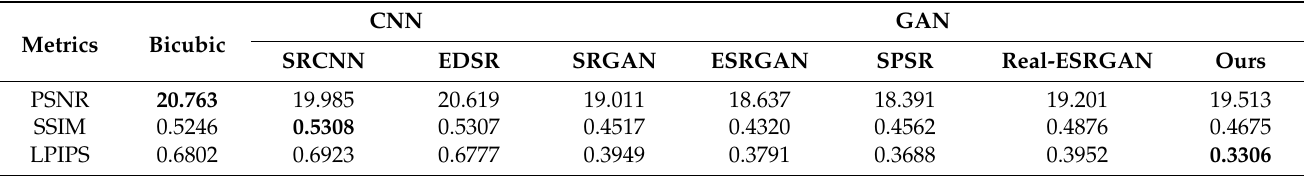
Table 3. Mean values of PSNR, SSIM and LPIPS for different methods. The best performance in bold. CNN GAN Metrics Bicubic SRCNN EDSR SRGAN ESRGAN SPSR